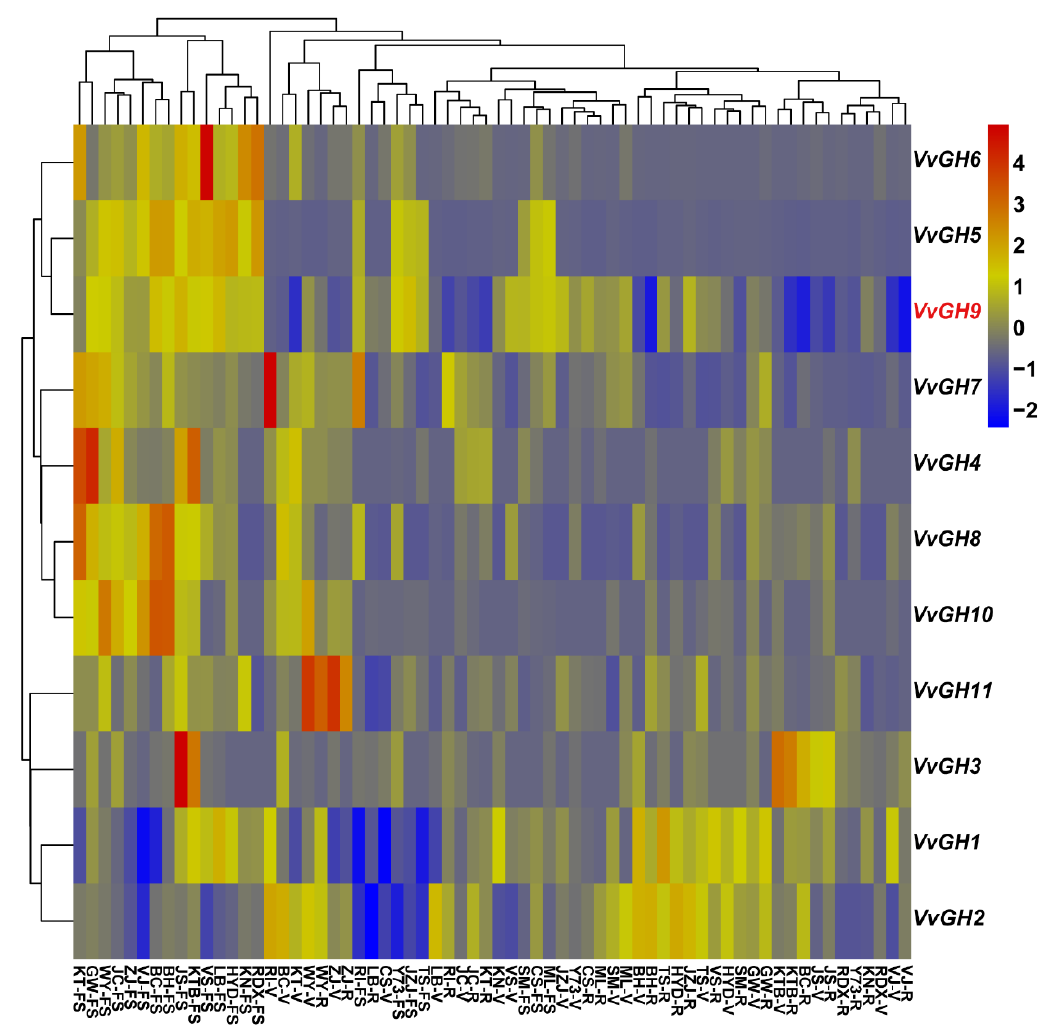
Figure 3. Expression profiles of VvGH genes at 3 developmental stages of 22 grape varieties. The expression levels of these genes were downloaded from the grape-RNA database. The color intensity represents relative expression levels, with red as increased transcript abundance and blue as decreased transcript abundance. The acronyms below the heatmap represent grape varieties (Table S2). FS: fruit set. V: véraison. R: ripe.